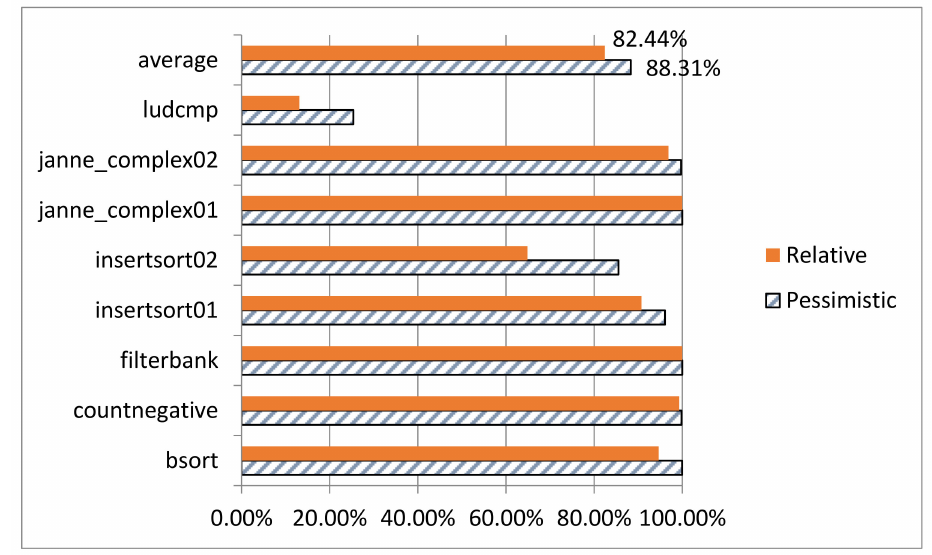
Figure 7. The reductions of WCET overestimations on a simple processor.